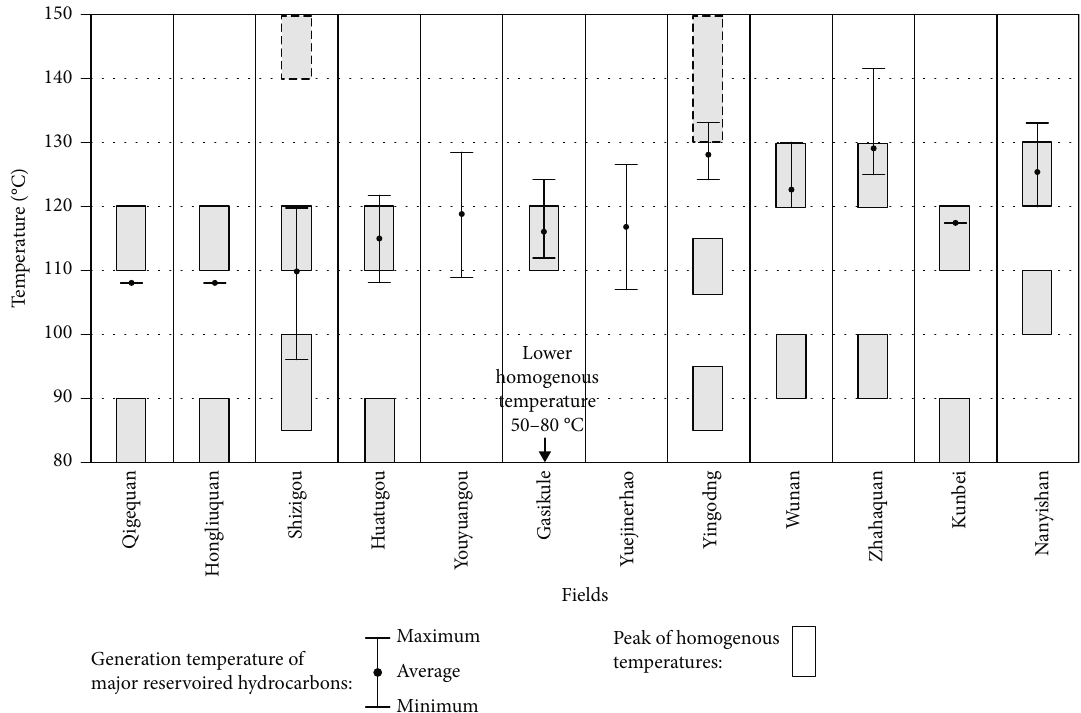
Figure 8: Relationship between generation temperature of major reservoired hydrocarbons (GTMRH) and peaks of homogenization temperature in di ff erent oil fi elds in the western Qaidam Basin. Supplementary GTMRH data for the Qigequan, Hongliuquan, Shizigou, Huatugou, Youyuangou, Gasikule, and Yuejinerhao oil fi elds are from Zhu et al. [31]. Peak homogenous temperature of fl uid inclusion data for the Qigequan and Hongliuquan fi elds are from Fu et al. [1], Shizigou is from Li et al. [25], Huatugou is from Liu et al. [26], Gasikule and Nanyishan are from Li et al. [27], Yingdong is from Sui et al. [28], Zhahaquan is from Wang et al. [29], and Kunbei is from Chen et al. [30]. Solid border of the peak homogenous temperature is presented in published articles; the dotted border peak is based on latest